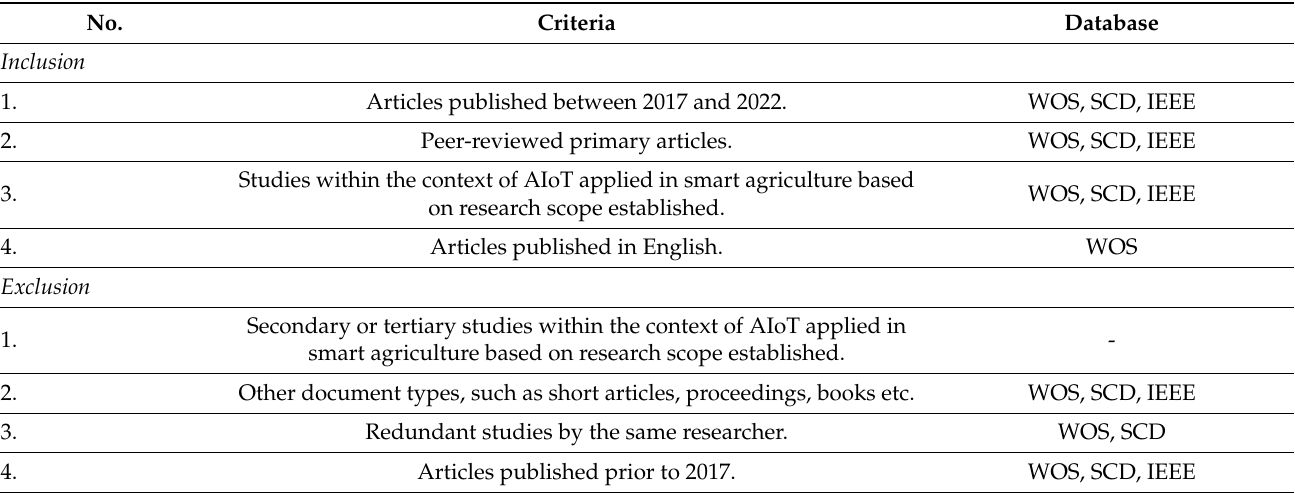
Table 3. Inclusion and exclusion criteria.